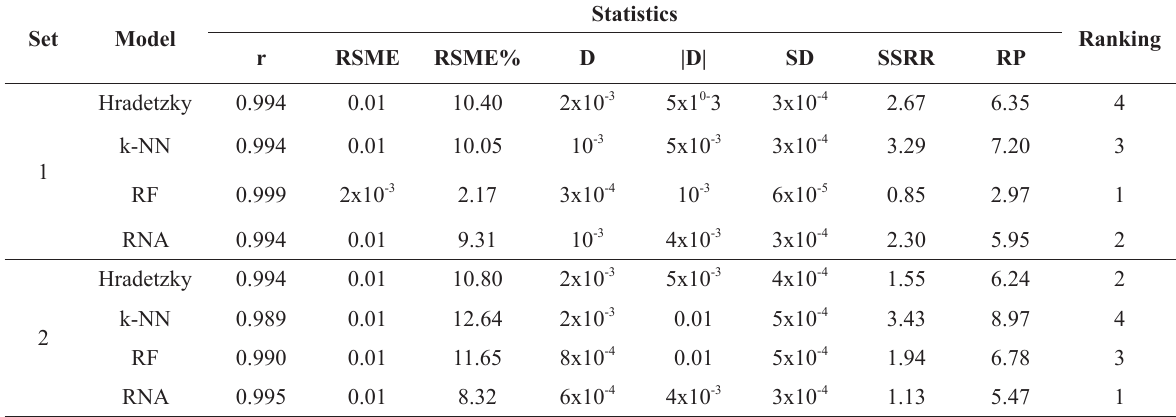
Fit statistics for estimation of stem total volume for training (1) and validation (2) sets.